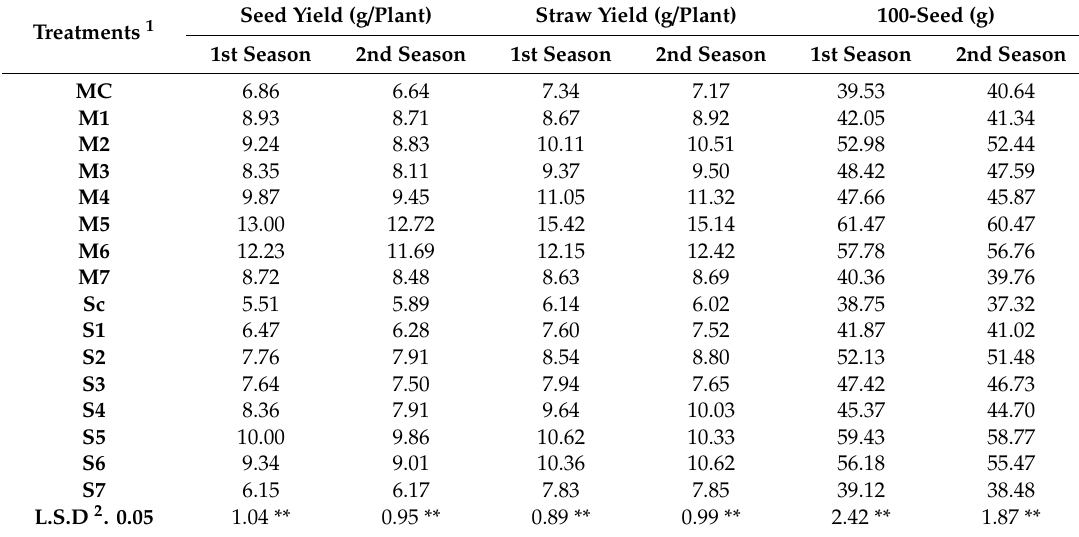
Table 8. E ff ect of spent mushroom substrate extract (SMSE), mushroom culture filtrate (MCF), and Roundup ® treatments to control broomrape infestation on faba bean yield parameters at harvesting stage during two